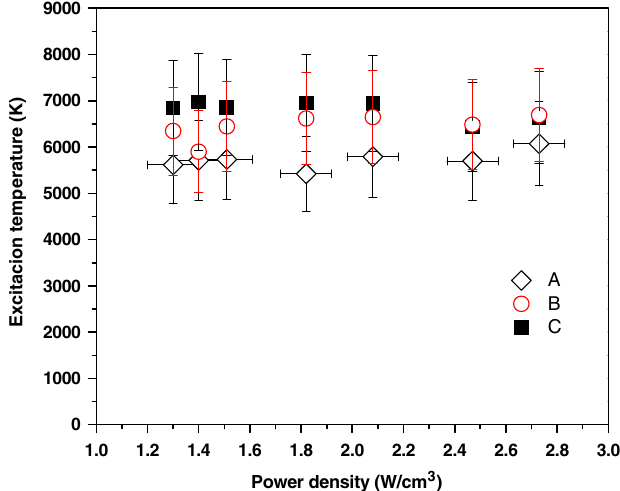
FIG. 4. Excitation temperature in the absence of Nb sample as a function of power density. Error bars reflect the statistical error of the individual sets of data and the uncertainty in local power density. Sets A, B, and C correspond to Table I. Experimental conditions: pressure 1 Torr and the gas mixture Ar = Cl 2 ratio 97:3 .